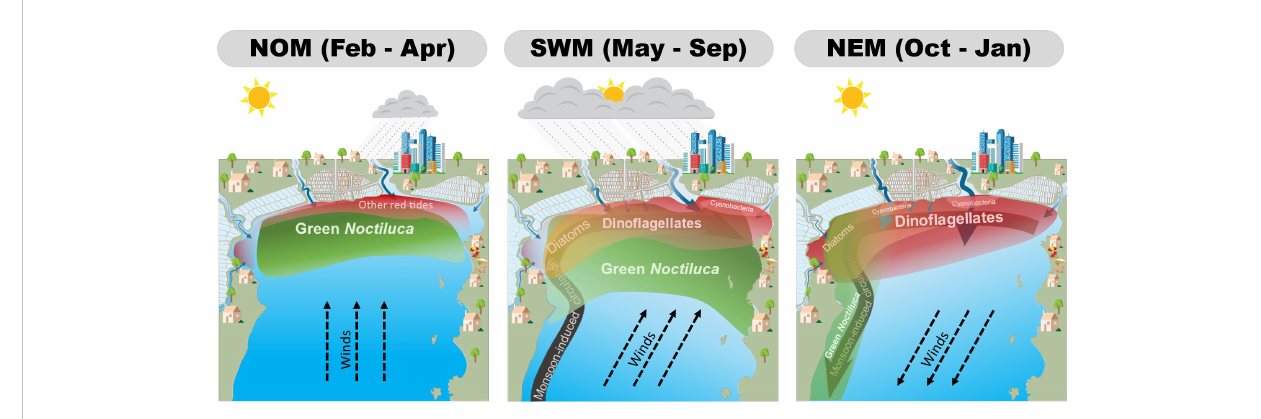
FIGURE 9 Synopsis of the seasonal dynamics of uGoT red tides under non-monsoon (left), southwest monsoon (middle), and northeast monsoon (right)